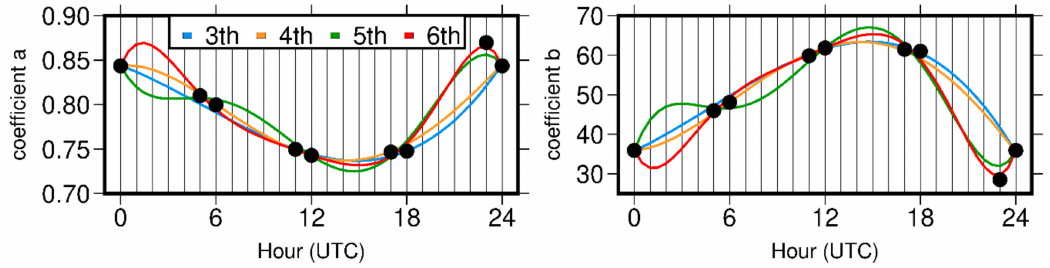
Figure 5. Results of fitting di ff erent degree polynomials into T m − T s linear regression coe ffi cients: a (left) and b (right). Color of the line denotes degree of the polynomial: 3rd—blue, 4th—orange, 5th—green,